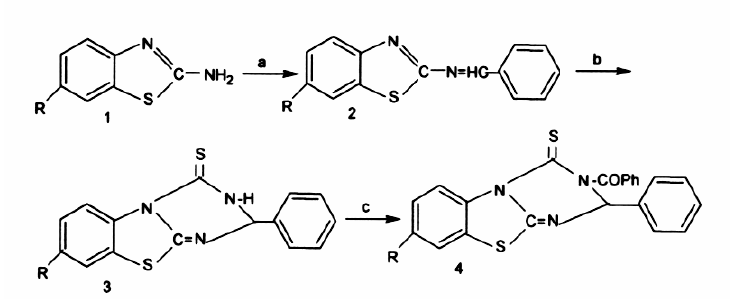
Figure 1. Reagents and Conditions : (a) Benzaldehyde, Ethyl alcohol, MWI for 1-1.5 minutes (b) NH SCN,1,4-dioxane, MWI for 1.5-2.0 minutes (c) PhCOCl, Pyridine, in cold 4 conditions. Table 1. Physico-Chemical data of synthesized compounds (C.M.=Conventional